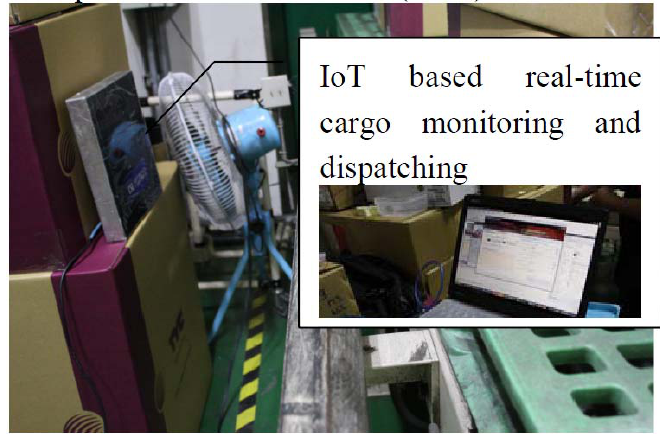
Figure 4. IoT-technology-enabled real-time cargo monitoring and dispatching through computers and work stations (to-be).